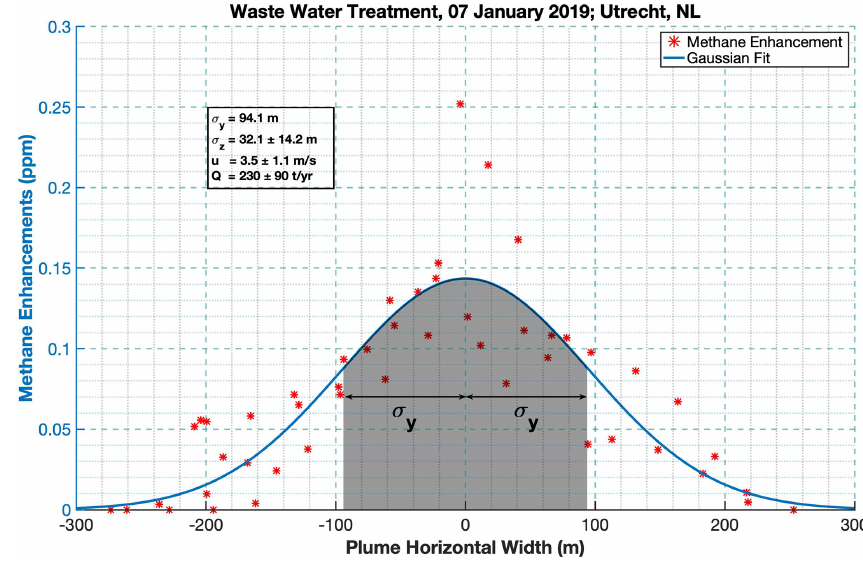
Figure 7. Gaussian curve fitted to some transects downwind of the waste water treatment plant in Utrecht. Table 3. CH 4 emissions from larger facilities in Utrecht and Hamburg estimated with the Gaussian plume